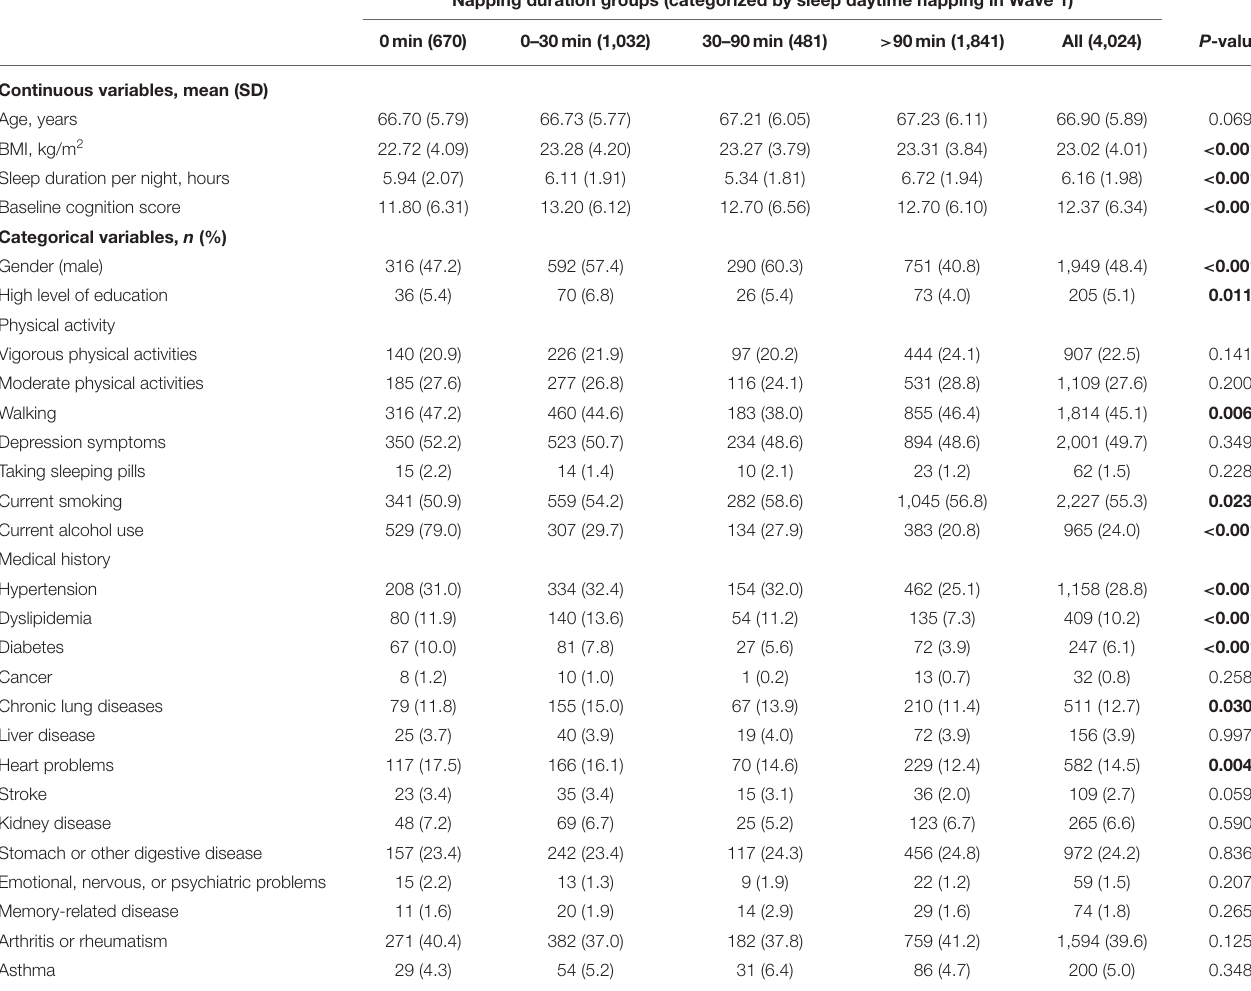
TABLE 1 | Demographic and health characteristics of the study population at